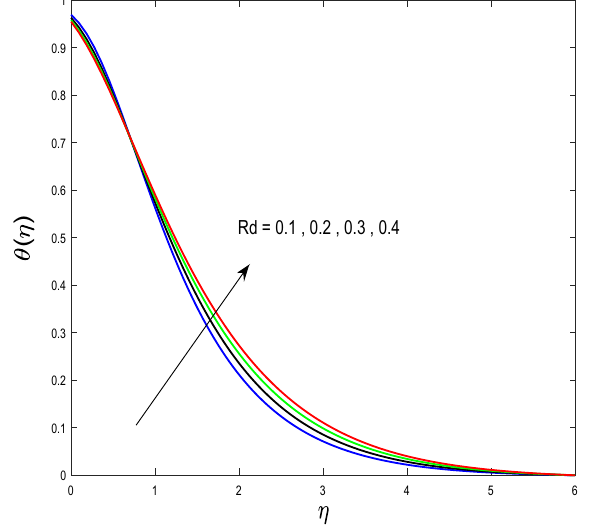
Figure 11. Plot of θ for Rd .